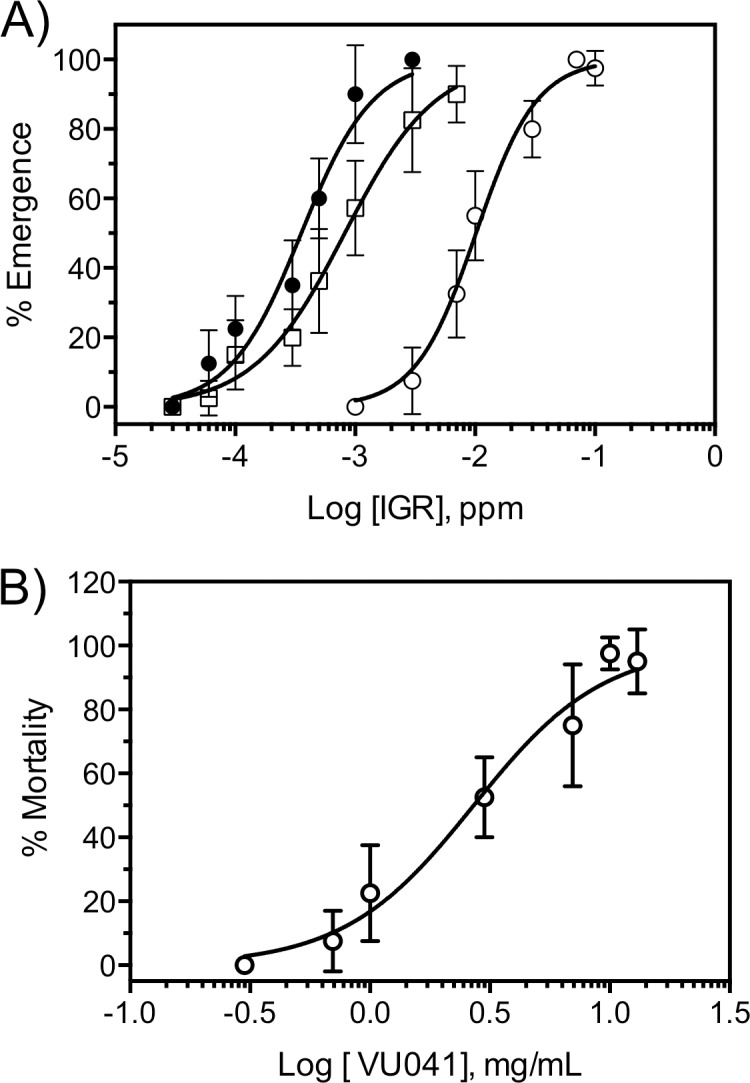
Toxicity of IGRs and VU041 to An. quadrimaculatus.A) Concentration-response curves of triflumuron (closed circles), pyriproxyfen (open squares), and novaluron (open circles) as determined by inhibition of adult emergence after exposure to 4th instars. Each data point represents an average (n = 3) toxicity and each replicate consisted of 30 larvae; totaling 90 mosquitoes. Error bars represent SEM. B) Toxicity in blood fed, adult An. quadrimaculatus 24h after contact exposure to netting treated with VU041. Data points represent a mean mortality (n = 4–8 replicates of 25 mosquitoes tested per dose) and error bars represent SEM.